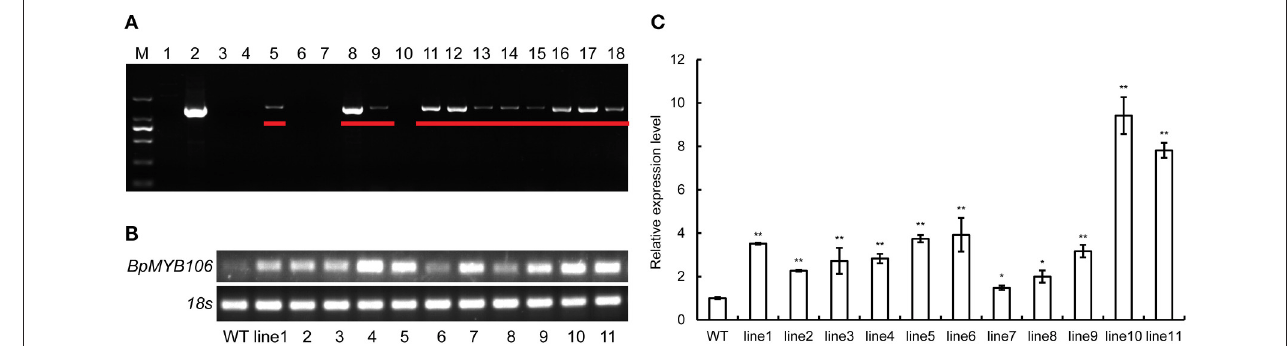
FIGURE 5 | PCR analysis of BMYB106 in WT and transgenic lines of birch. (A) PCR of 35S::BpMYB106 transgenic lines. M, DNA Marker DL2000; 1, WT plant; 2, positive control (pROKII- BpMYB106 ); 3–18, 35S::BpMYB106 transgenic lines. Underlined showed the electrophoresis result of PCR productions. (B) Semi-quantitative RT-PCR analysis of BpMYB106 . WT, wild-type plant; lines 1–11; 11 PCR-positive lines. (C) Quantitative RT-PCR analysis of BpMYB106 . Genes were normalized using 18S as housekeeping genes. Error bars on each symbol indicate the mean ± SE of three replicate reactions, and statistically significant differences are indicated ( * P < 0.05 and ** P < 0.01 by two-tailed t -test and one-way ANOVA).